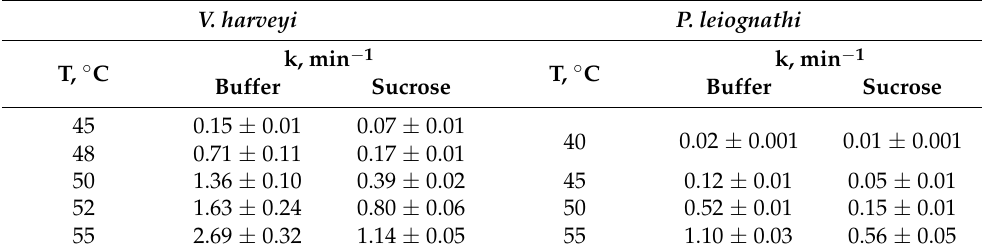
Table 1. The thermal inactivation rate constants for the P. leiognathi and V. harveyi luciferases in the buffer and sucrose solutions (30%) at different temperatures.